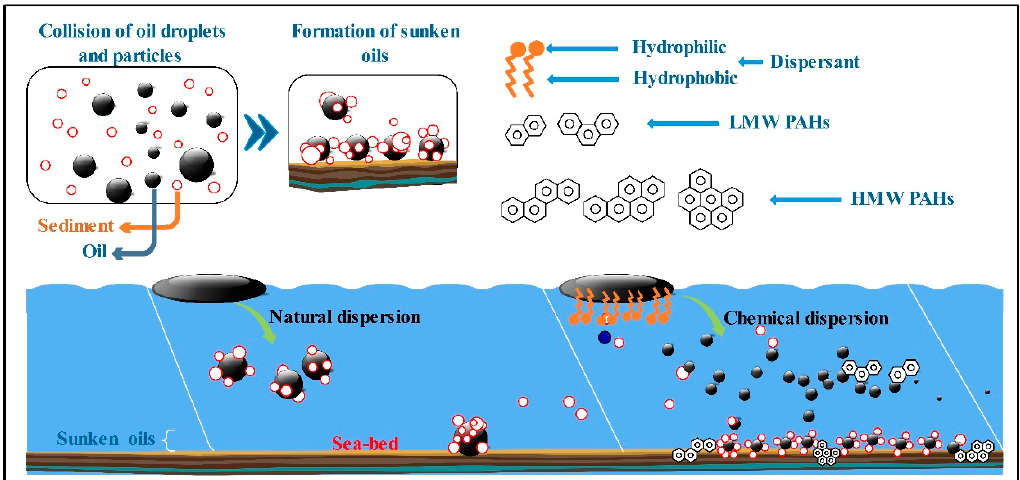
Figure 7. Schematic description of the interaction between oil and sediment in the presence of chemical dispersant.